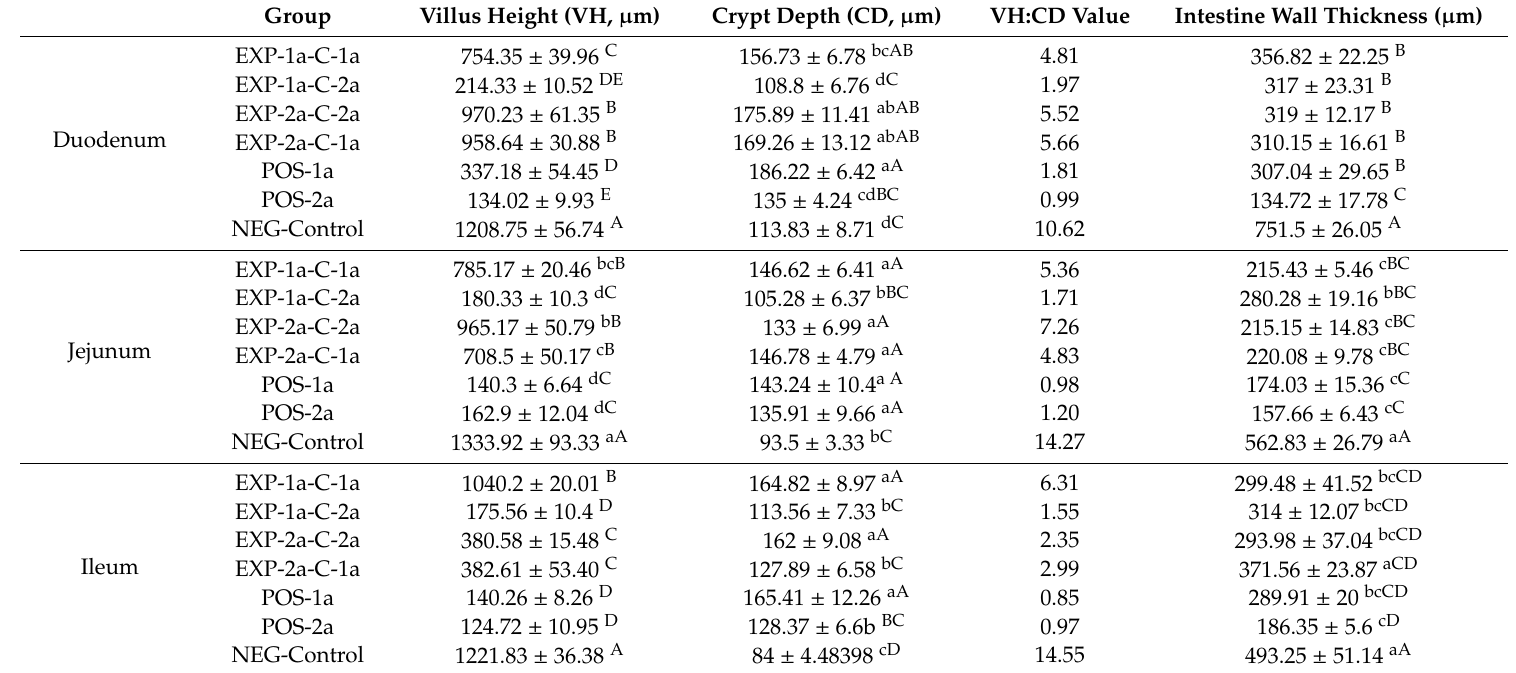
Table 2. E ff ects of di ff erent treatment on villus height, crypt depth, and thickness of intestine wall of